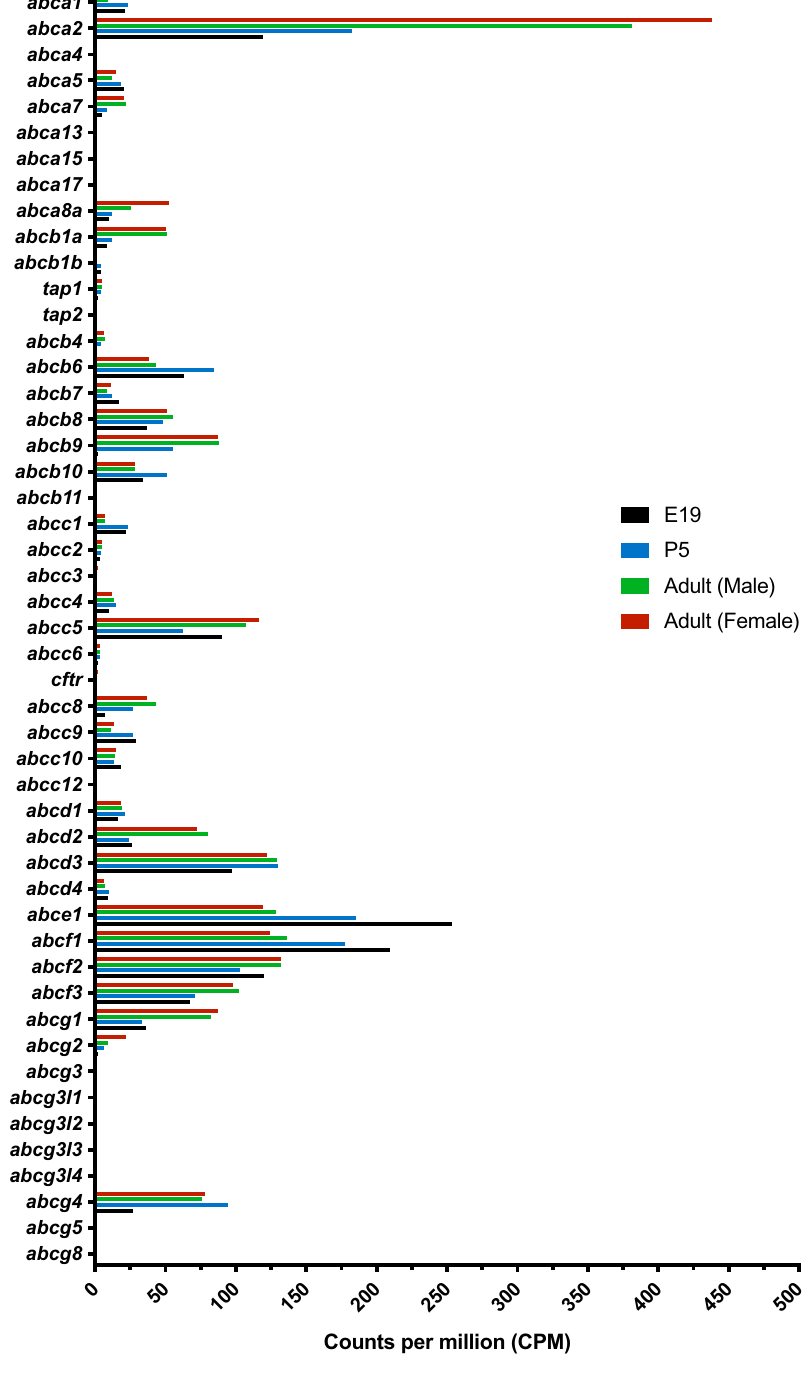
Figure 1. Expression of ABC transporters identified in rat brain at different ages. Average, normalized counts per million (CPM) for ABC transporters in brain at different ages (n = 4) as measured by RNAseq using EdgeR analysis. Ages indicated by colours: black E19, blue P5, green male adult, red female adult. In general expression levels appear to be similar at all ages or higher in the adult. But a few were higher in the fetus ( abce1 , abcf1, abcc9, abcc1